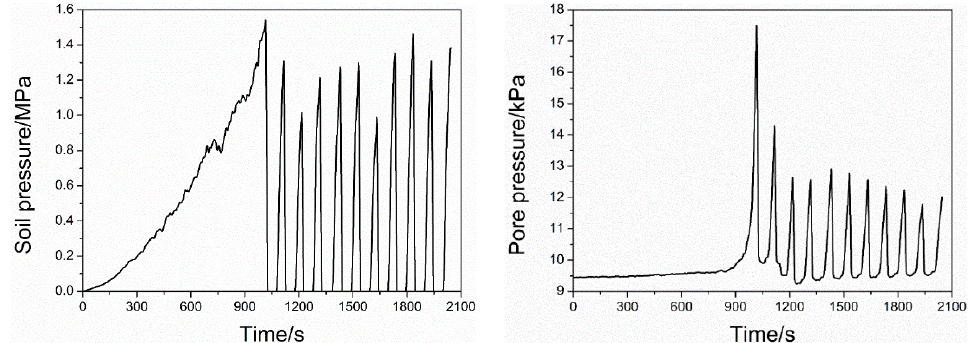
Figure 18. End-soil pressure and pore pressure.